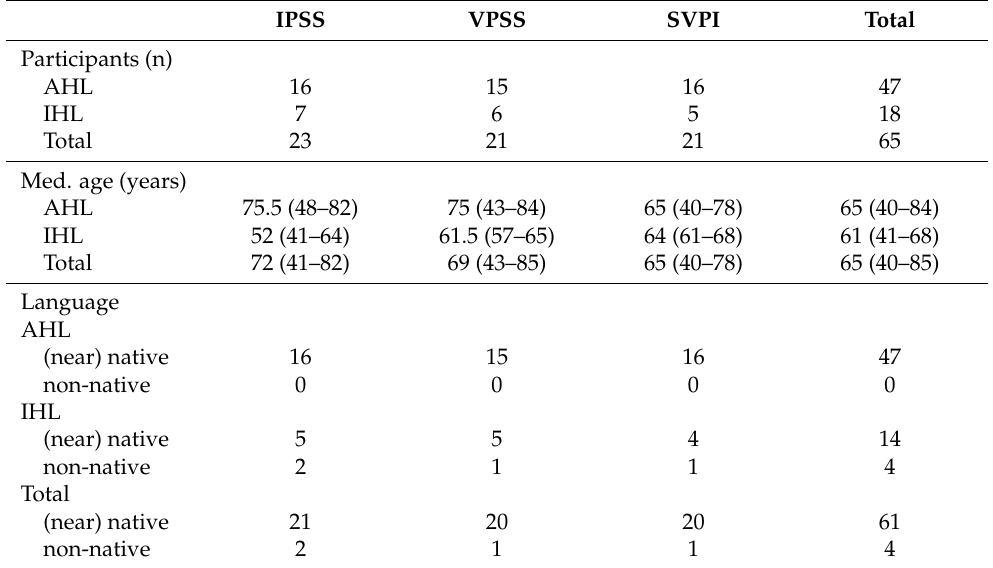
Table 1. Participant